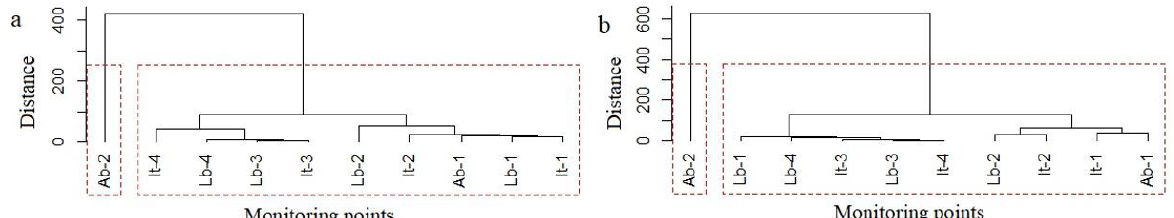
Figure 8. Dendogram for spatial analysis using the WARD method for the dry season (a) and for the rainy season